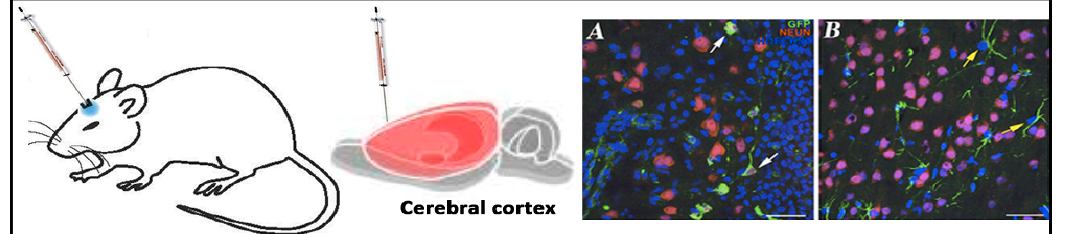
Figure 7. In vivo applications of niosomes in brain. ( A ) White arrows in the right side indicated identified neurons (red) that express EGFP (green). ( B ) Non-neuron cells (NeuN − ) with glia morphology that express EGFP (green) were indicated by yellow arrows. Adapted with permission from Ojeda et al. [51]. Copyright 2017, Elsevier